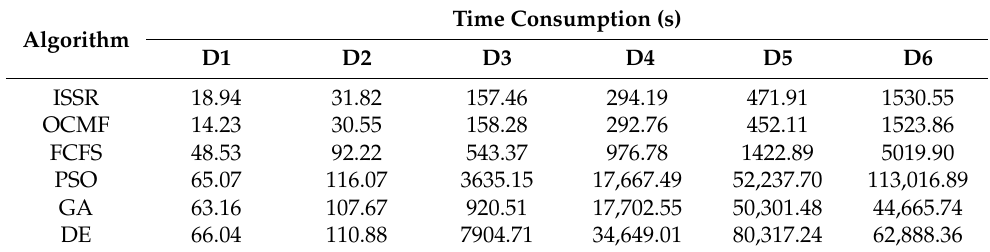
Table 4. Time cost calculation results for multiple algorithms on different